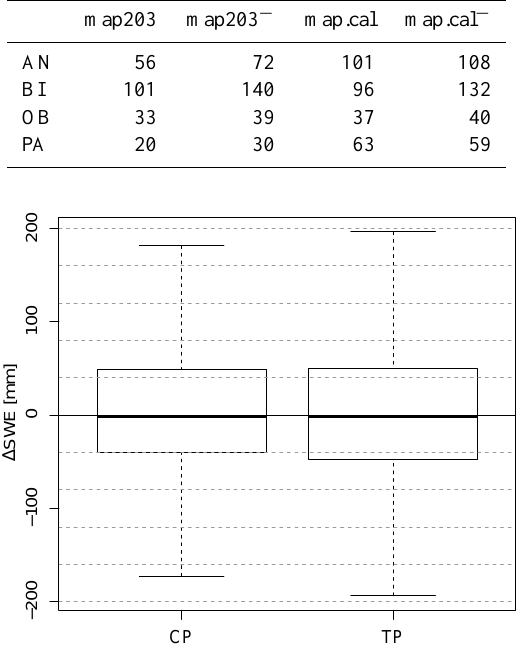
Fig. 10. Mean differences in the calibrated and observed SWE at 23 stations for the calibration period (CP) and the test period (TP). Box and whiskers are shown as in Fig.